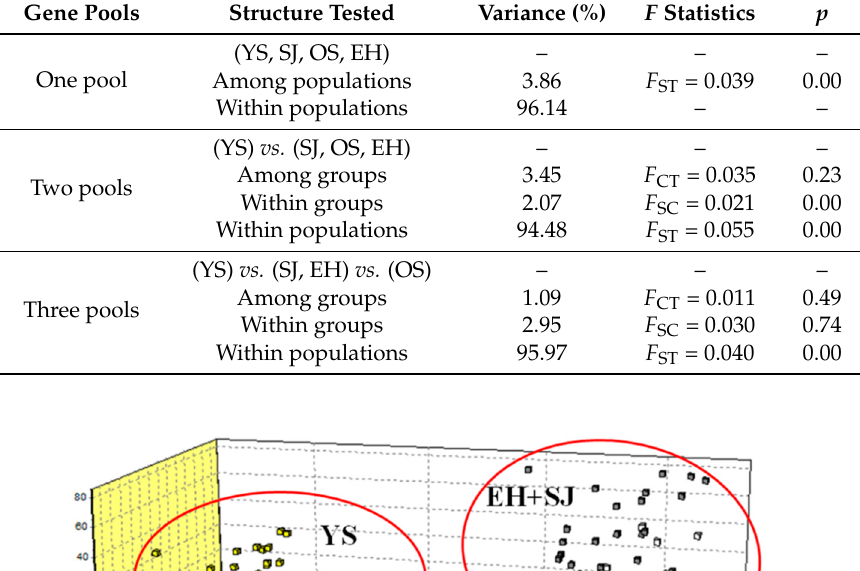
Table 3. The analysis of molecular variance of Pacific cod.